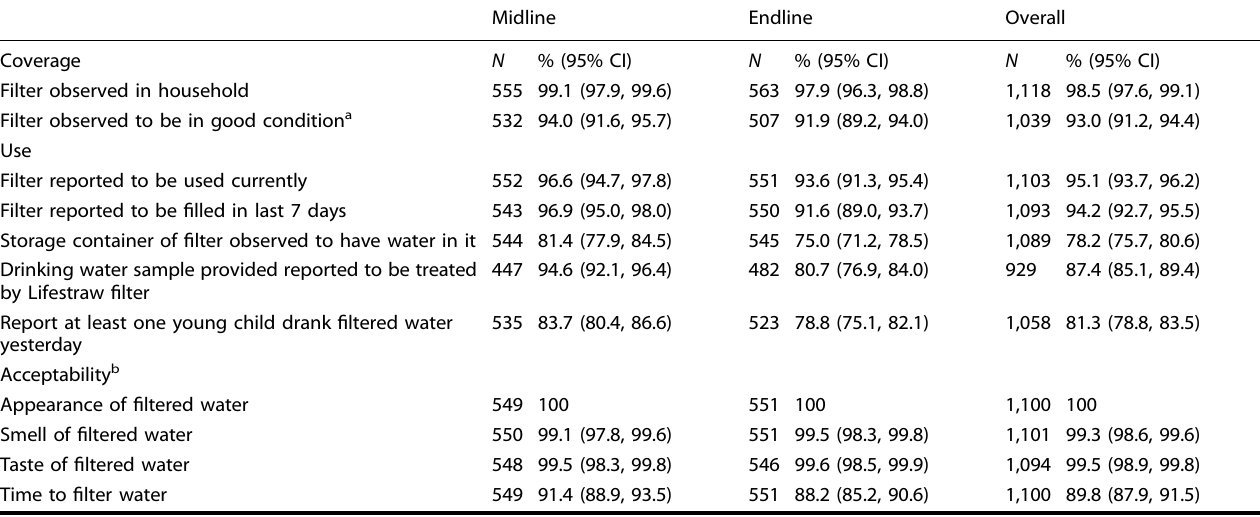
Table 2. Coverage, use, and acceptability of fi lter at midline and endline in intervention